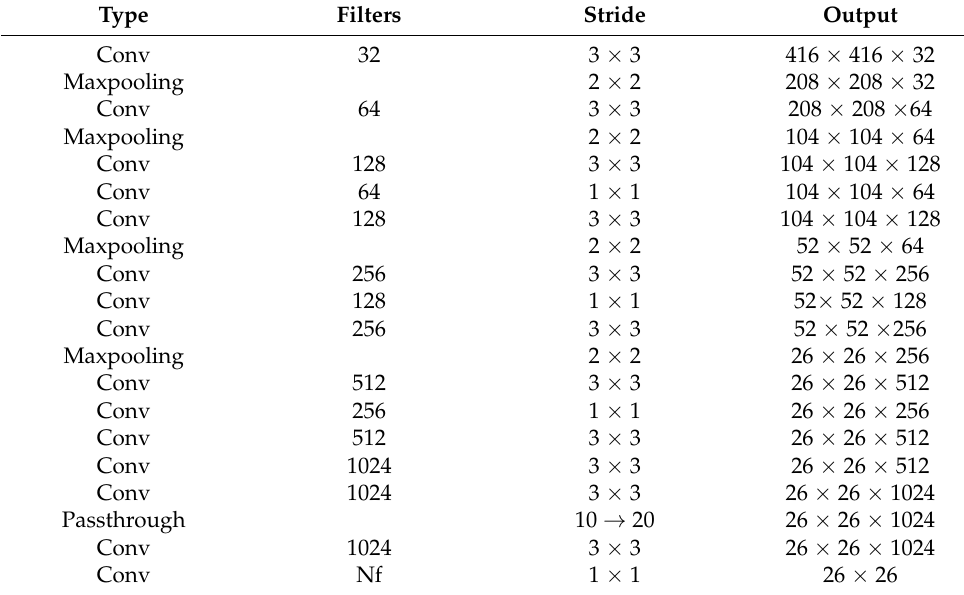
Table 1. Architecture of SIMRDWN (CNN with Maxpooling and convolutional